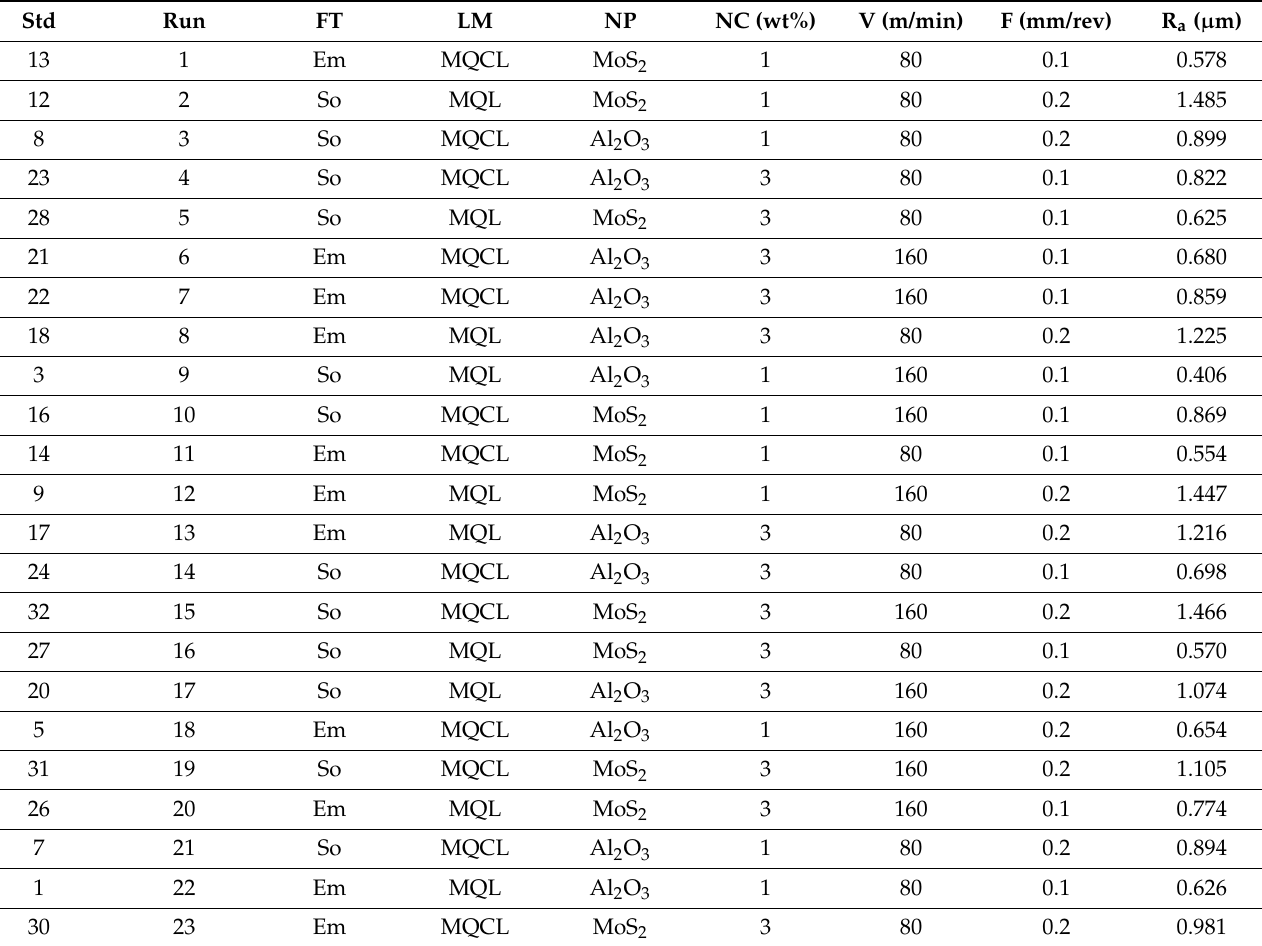
Table 5. Experimental